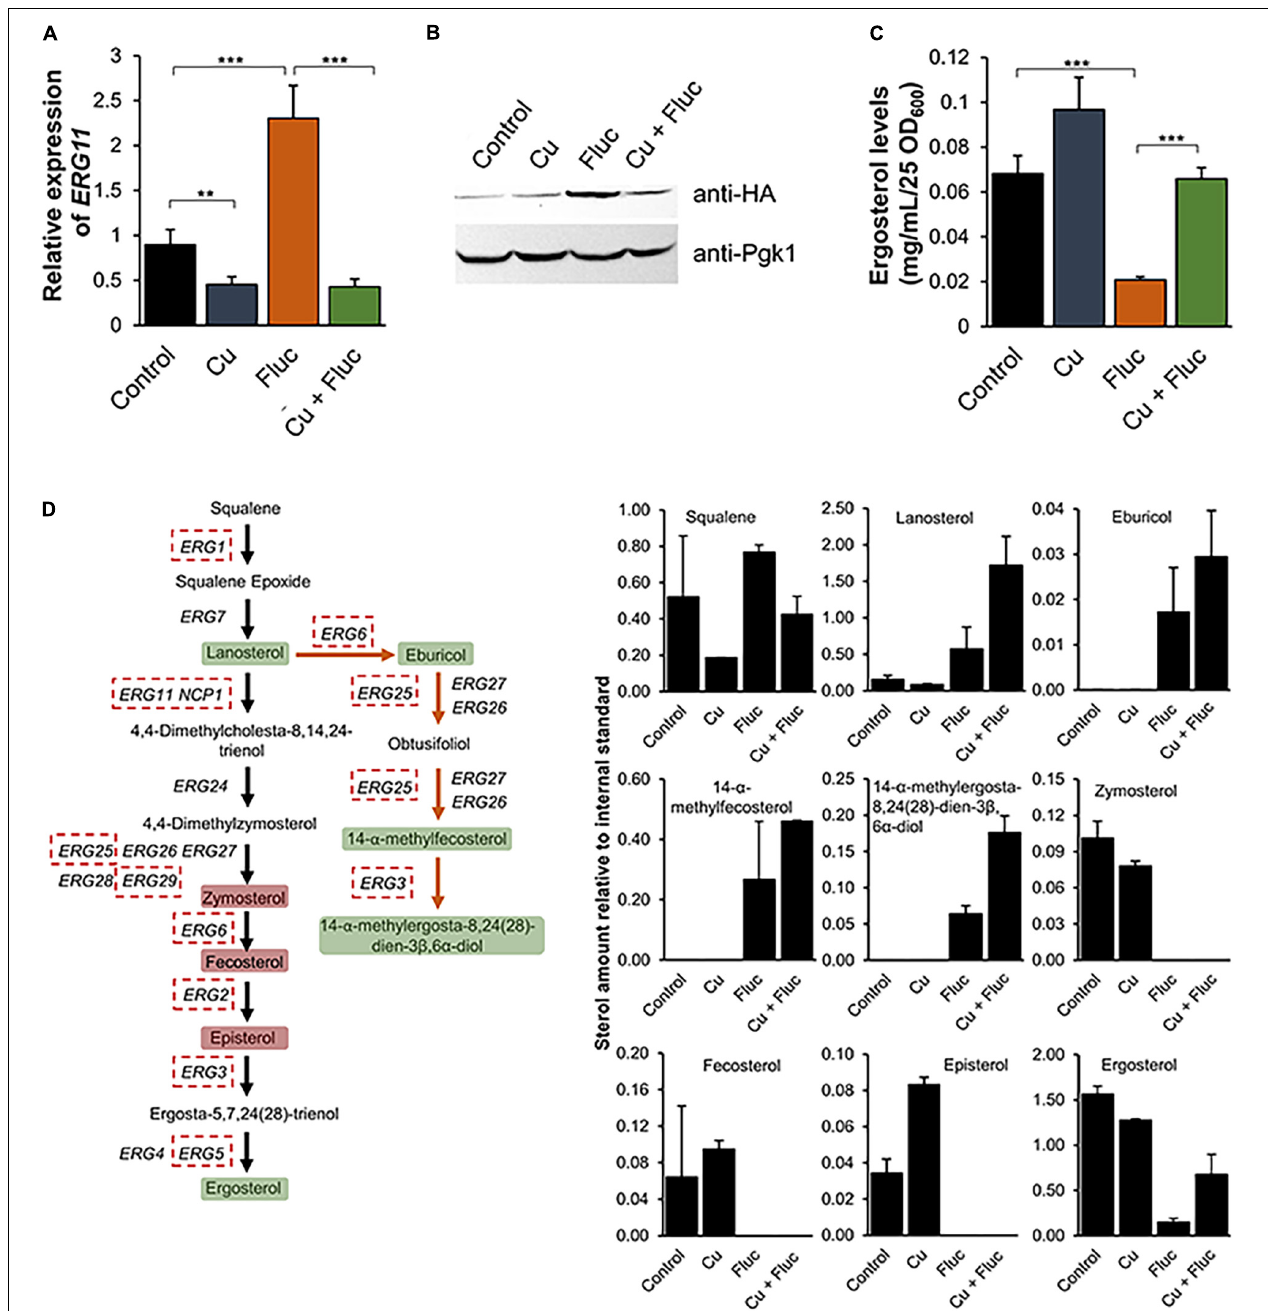
FIGURE 6 | The combination of copper and fluconazole affects ergosterol metabolism. (A) The expression of the ERG11 gene was determined by qRT-PCR in Candida glabrata cells untreated (Control) or treated with 1.25 mM CuSO 4 (Cu), 32 µ g/mL fluconazole (Fluc), or with the two compounds (Cu + Fluc). (B) Western blot analyses of a HA-tagged version of Erg11, after treatment with 625 µ M CuSO 4 , 32 µ g/mL fluconazole, or both for 2 h 30 m. (C) The ergosterol content of cells left untreated (Control) or treated with 625 µ M of CuSO 4 , 32 µ g/mL fluconazole (Fluc), or Cu + Fluc was measured by HPLC. Significance of differences was calculated using Student’s T -test (** p -value < 0.05; *** p -value < 0.005). (D) Schematic representation of the effect of Cu + Fluc on the biosynthesis of ergosterol. Dashed red boxes indicate the genes downregulated under Cu + Fluc treatment compared to fluconazole treatment, according to RNA-Seq analyses. Green boxes indicate sterol metabolites, which are more abundant after Cu + Fluc treatment, as compared to cells treated with fluconazole alone. Red boxes indicate sterol metabolites undetected by GC-MS under Cu + Fluc and Fluc conditions. The graphs indicate the relative amount of sterol intermediates in cells left untreated (Control) or treated with 625 µ M of CuSO 4 (Cu), 32 µ g/mL fluconazole (Fluc), Cu + Fluc, as determined by GC-MS. Cholestane was used as an internal standard.